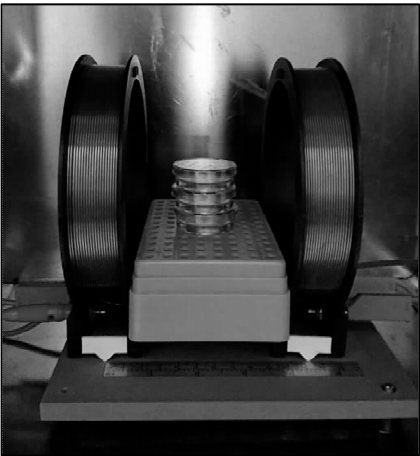
Figure 8. Exposure system constituted by a pair of Helmholtz Coils. The coils were placed inside a mu-metal box in a CO 2 incubator.